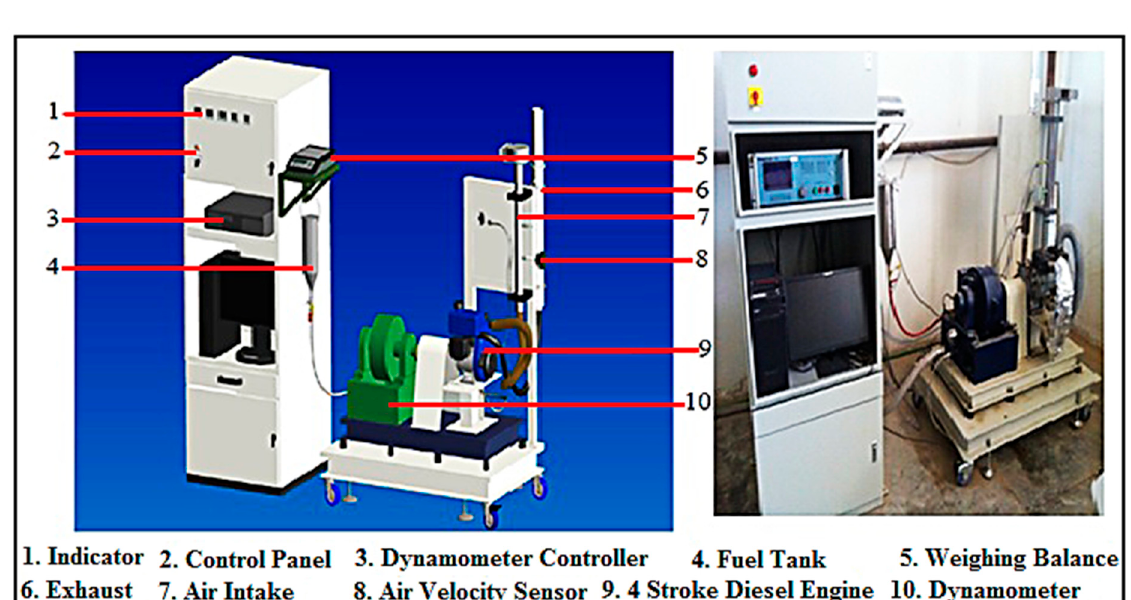
Figure 1. Schematic diagram of an experimental diesel test engine.